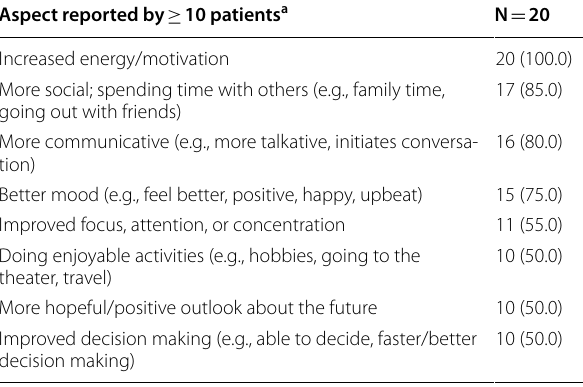
Table 2 Most frequently reported aspects of patient life